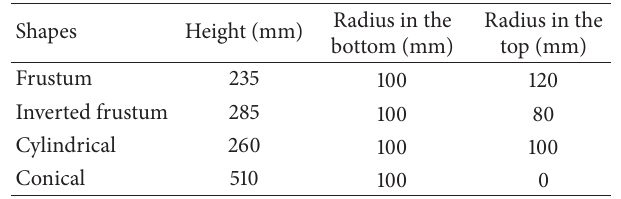
Table 1: Design parameters of the receiver based on equal area- height method.